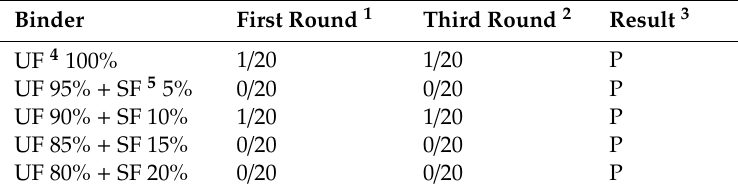
Figure 5. Shear strength (MPa) in three-layer plywood panels produced with urea-formaldehyde resin and 5%, 10%, 15%, and 20% soy flour substitution of UF resin. Table 2. Delamination test on plywood produced with di ff erent binders.